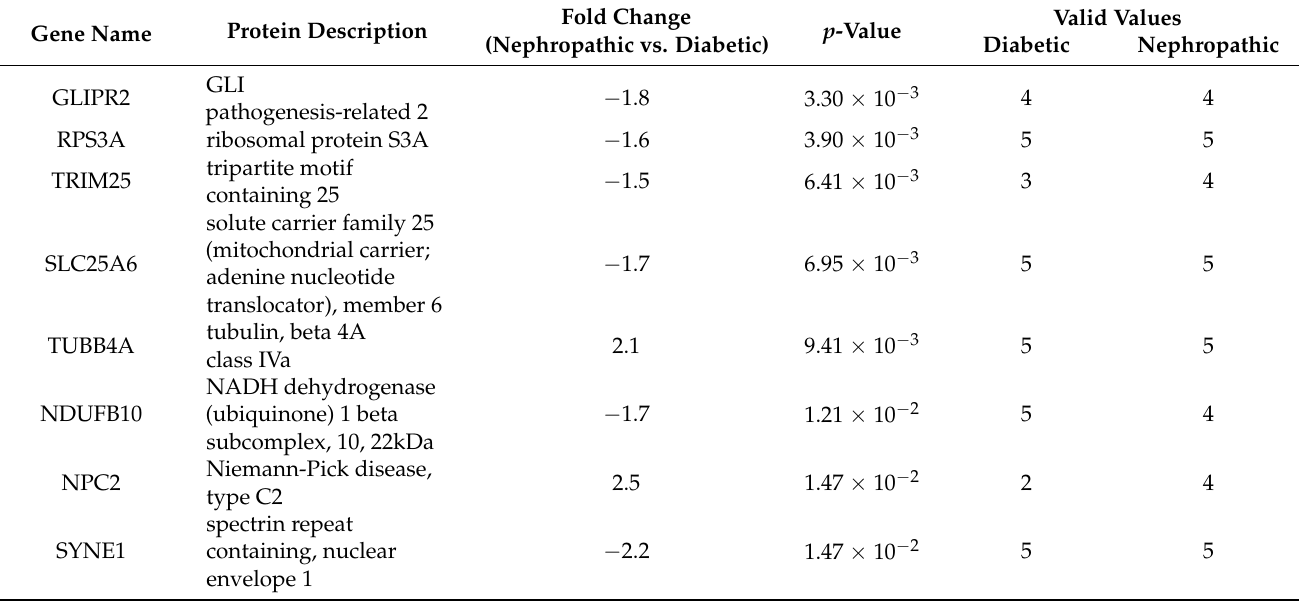
Table 3. Proteins with a significantly different abundance in Diabetic and Nephropathic